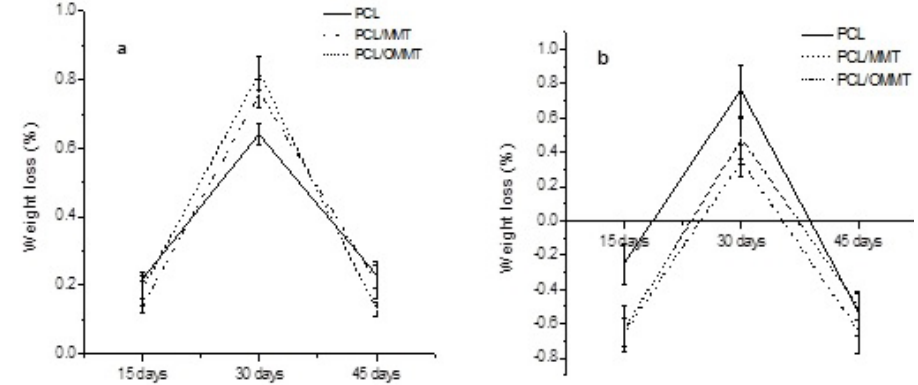
Figure 5. Weight loss during degradation experiments for PCL, PCL/MMT and PCL/OMMT compounds, experiments performed in (a) vacuum and (b) aqueous